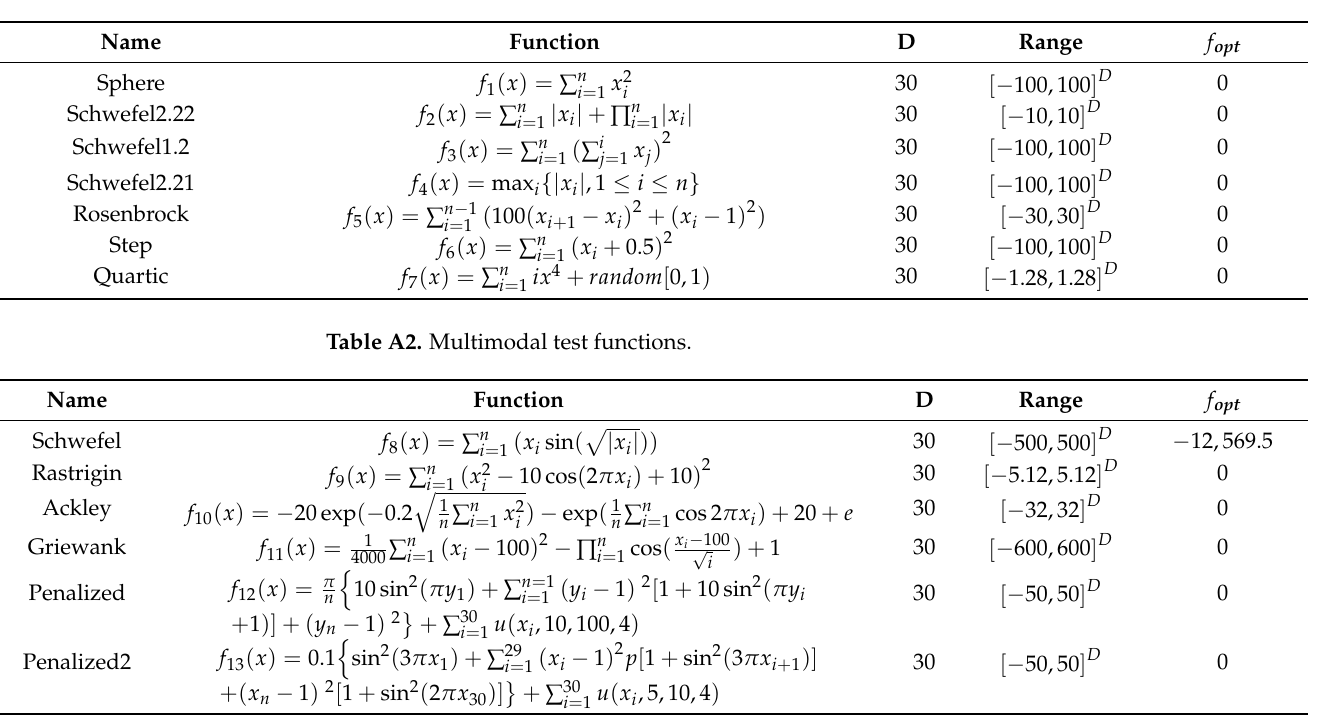
Table A1. Unimodal test functions.